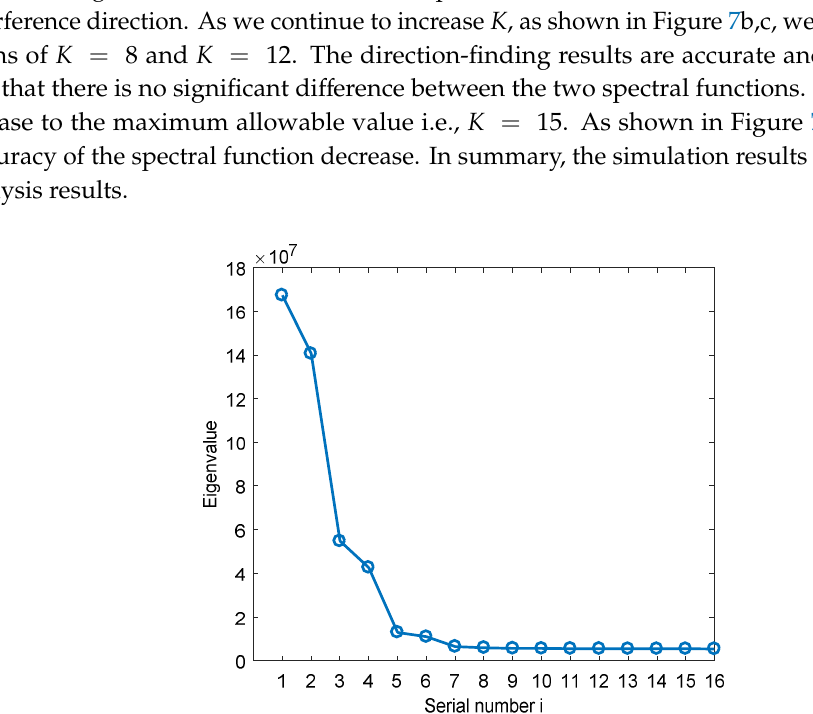
( d ) Figure 7. The normalized spectral function. ( a ) The normalized spectral function at